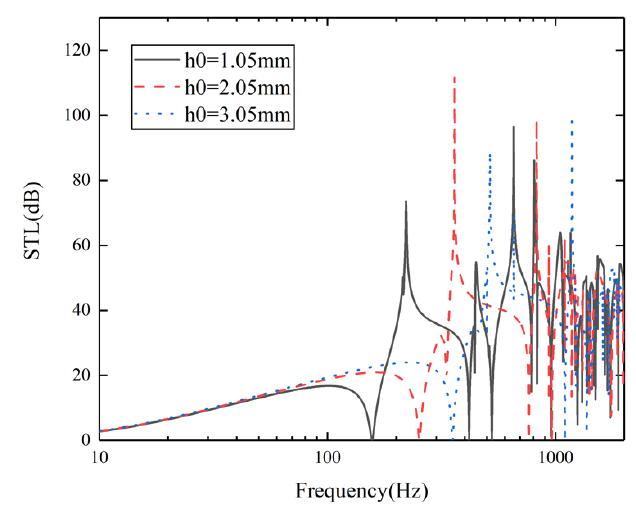
Figure 12. STL at different height of honeycomb core.